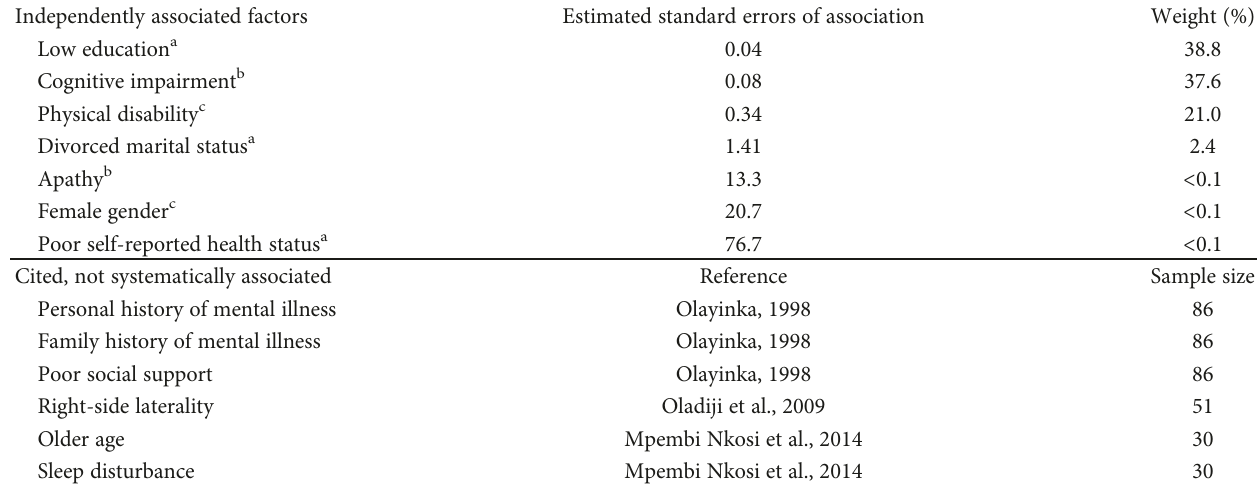
Table 2: The most common factors associated with poststroke depression in sub-Saharan